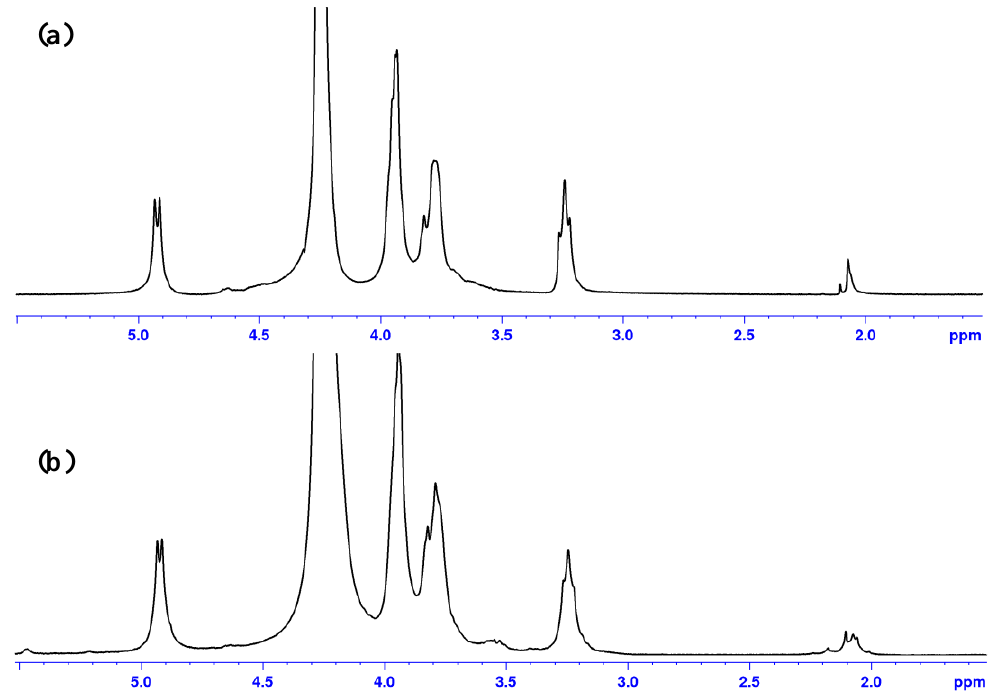
Figure 7. Influence of thermal treatment on 1 H NMR spectrum for film of chitosan obtained after chitosan solubilization in HCl in absence of thermal treatment ( a ); and after thermal treatment ( b ). Solvent D 2 O/DCl at 85 °C.